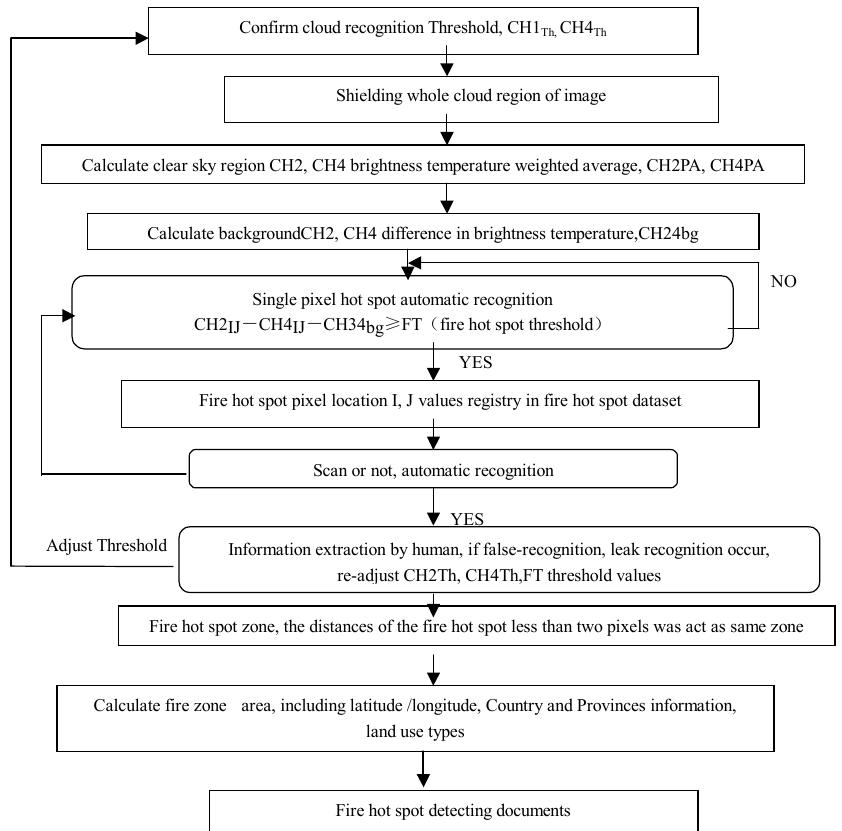
Figure 3 . Forest fire hot spot detecting flow chart using FY-2C/2D satellites